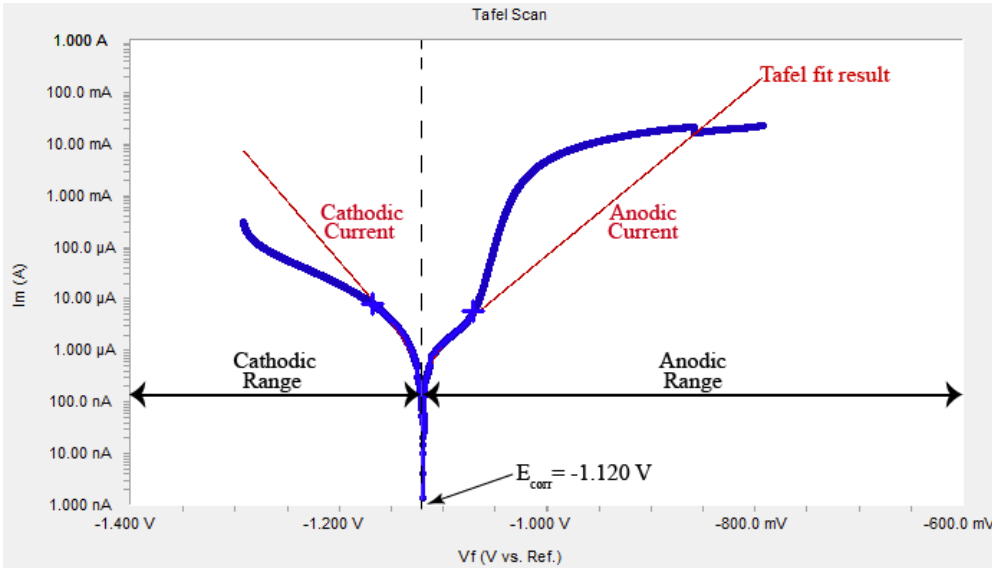
Figure 10. Tafel plot measurement result of wire arc sprayed Al-Zn coated sample.